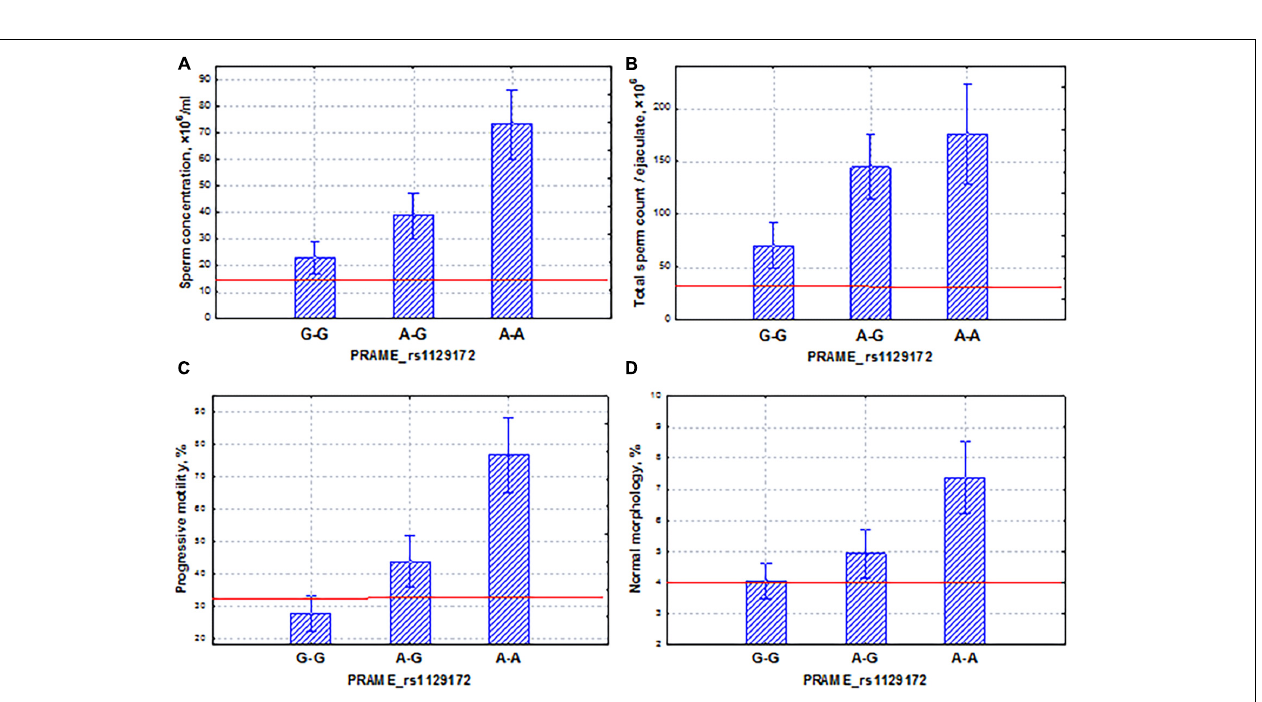
FIGURE 12 | Coordinated allelic effects of the SNP marker rs1129172 of the PRAME gene on semen quality parameters. (A) Sperm concentration, (B) total sperm count, and (C) proportion of motile, and (D) morphologically normal sperm. All the allelic differences were highly significant ( p < 0.05). The red lines indicate the WHO reference limits for different normal semen parameters [World Health Organization (WHO),